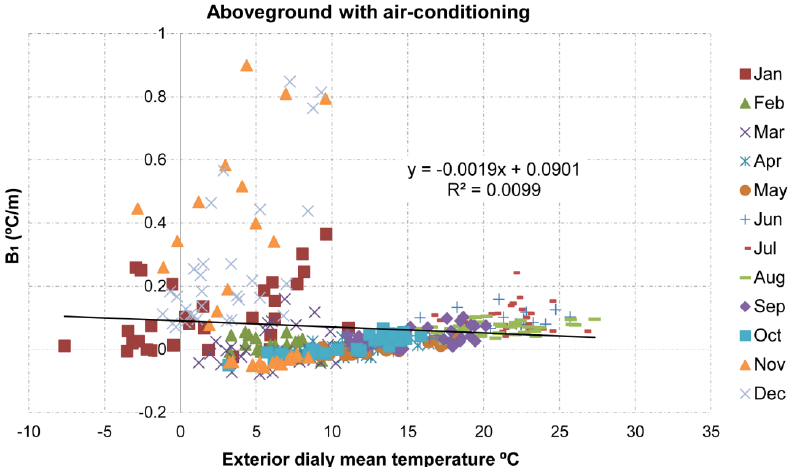
Figure 6. Relationship between the stratification of the indoor air in the air conditioned warehouse, measured through the β coefficients and the temperature of outdoor air. 1 Daily average values.